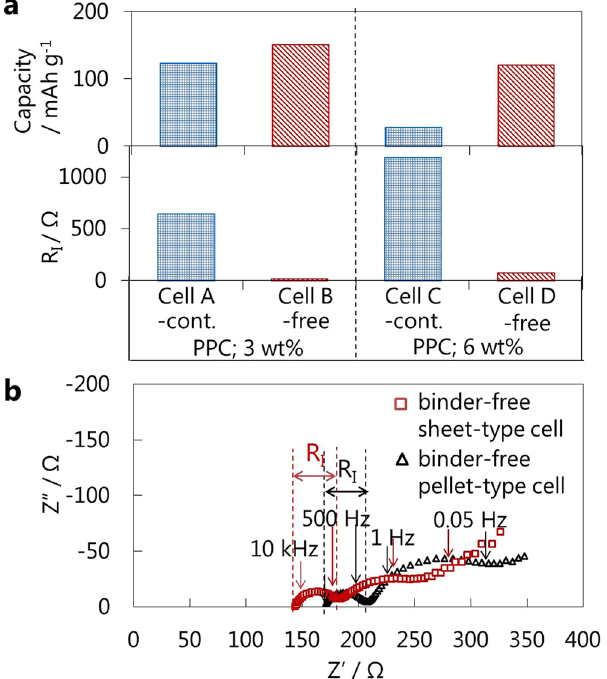
Figure 4. Effect of PPC content in the electrode on the cell performance. ( a ) Initial discharge capacities and R I after initial charging of binder-free and binder-containing positive half-cells using positive sheets with different PPC content, (NMC:f-LPS:AB:PPC = 80:20:2:x)/LPS/In. (x = 3, 6) ( b ) Impedance plots of the binder-free sheet-type cell, sheet (NCM:f-LPS:AB:PPC = 80:20:4:3)/LPS/In, and the binder-free pellet-type cell, powder (NCM:f-LPS:AB = 80:20:4)/LPS/In, measured after initial charging to 3.7 V vs. In-Li at a current density of 0.064 mA cm − 2 .